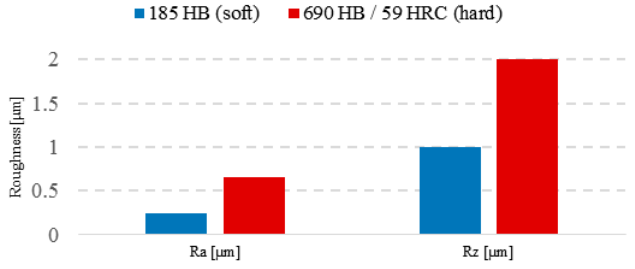
Figure 6. Comparison of mean surface roughness values of soft and hard machining with standard inserts of type 1030.